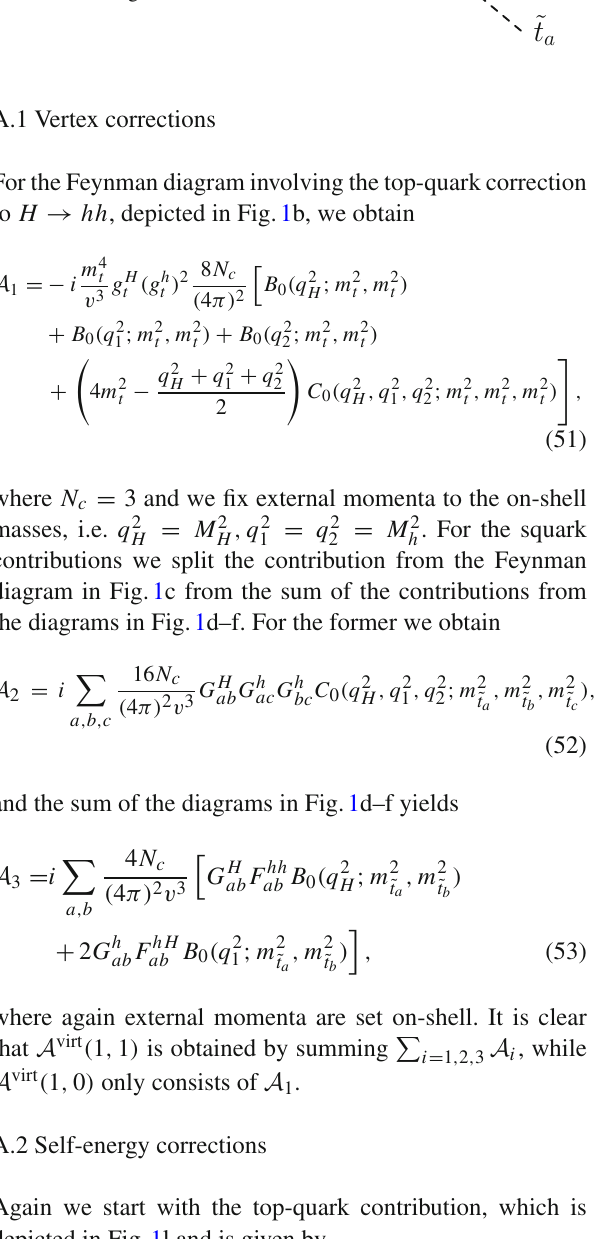
Fig. 8 Feynman rules for interactions of squarks and Higgs bosons. The indices i and j refer to color, the indices a and b to mass